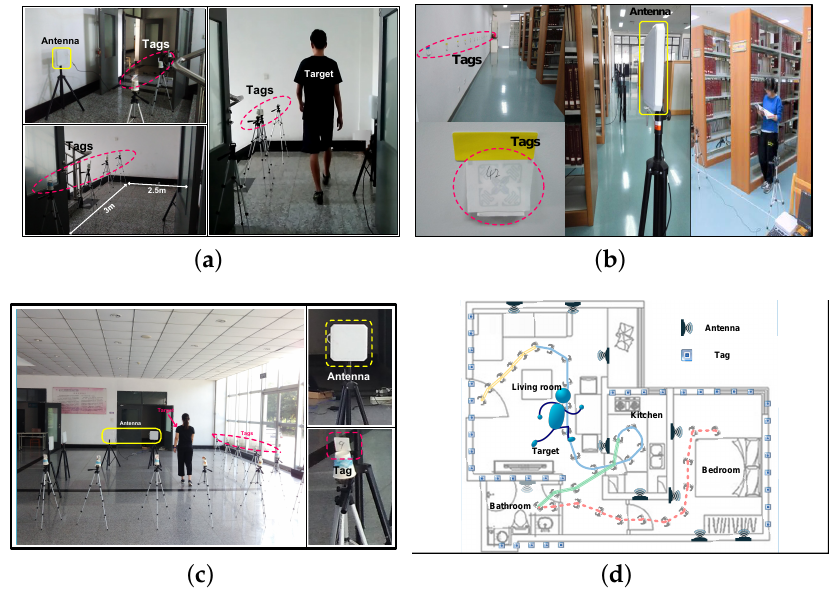
Figure 11. Different experimental environments. ( a ) RDTrack in the corridor; ( b ) RDTrack in the library; ( c ) RDTrack in the laboratory; ( d ) RDTrack in the